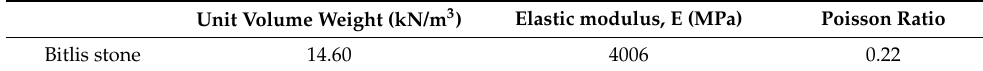
Table 8. Material properties [13,62].